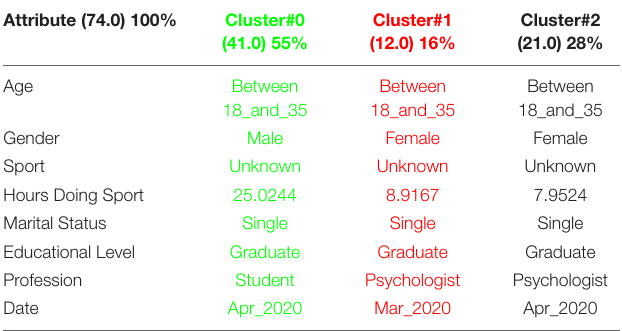
TABLE 6 | 3 clusters POMS analysis for March to May 2020.